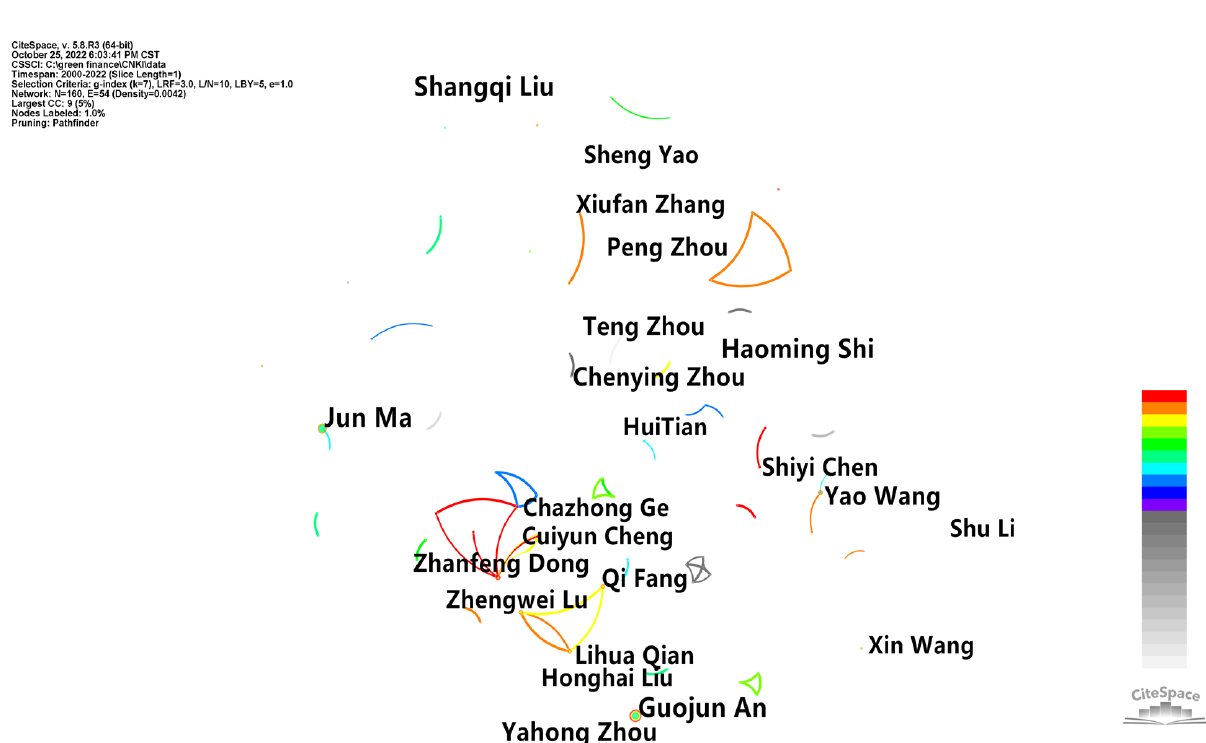
Figure 3. Domestic author cooperation chart.